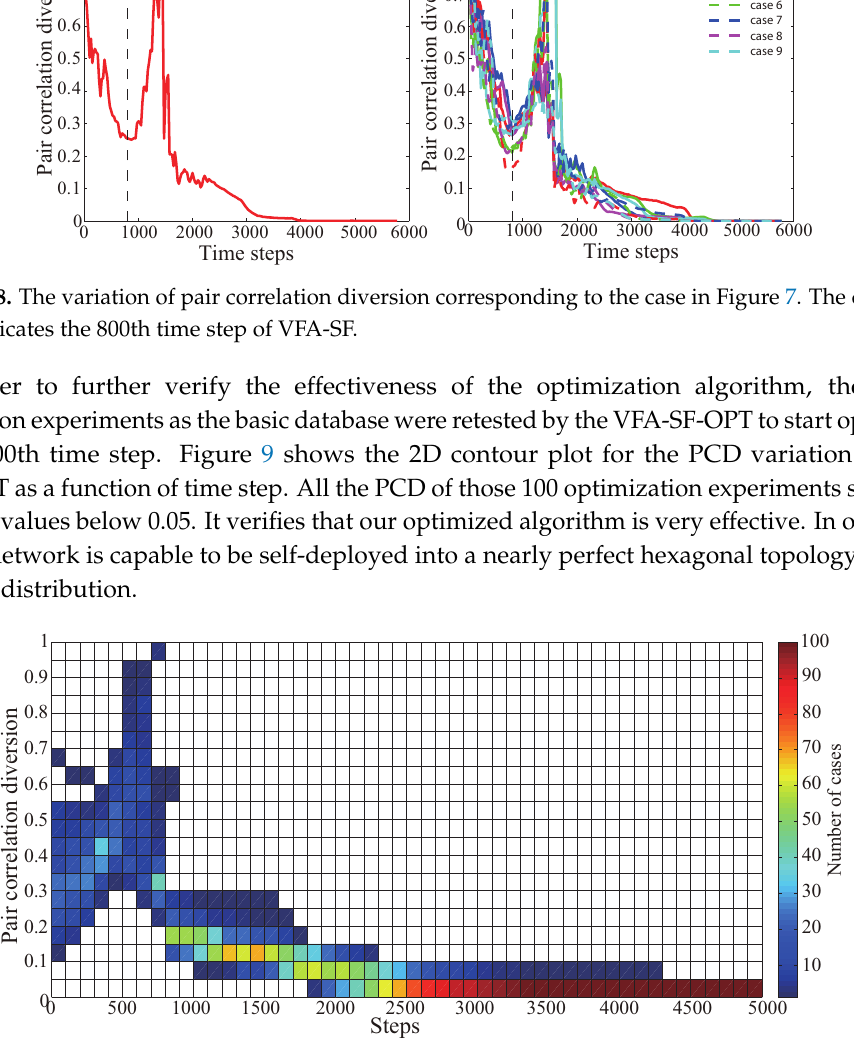
Figure 9. The 2D contour plot for the PCD variation only from VFA-SF-OPT as a function of time step, for 100 cases used in Figure